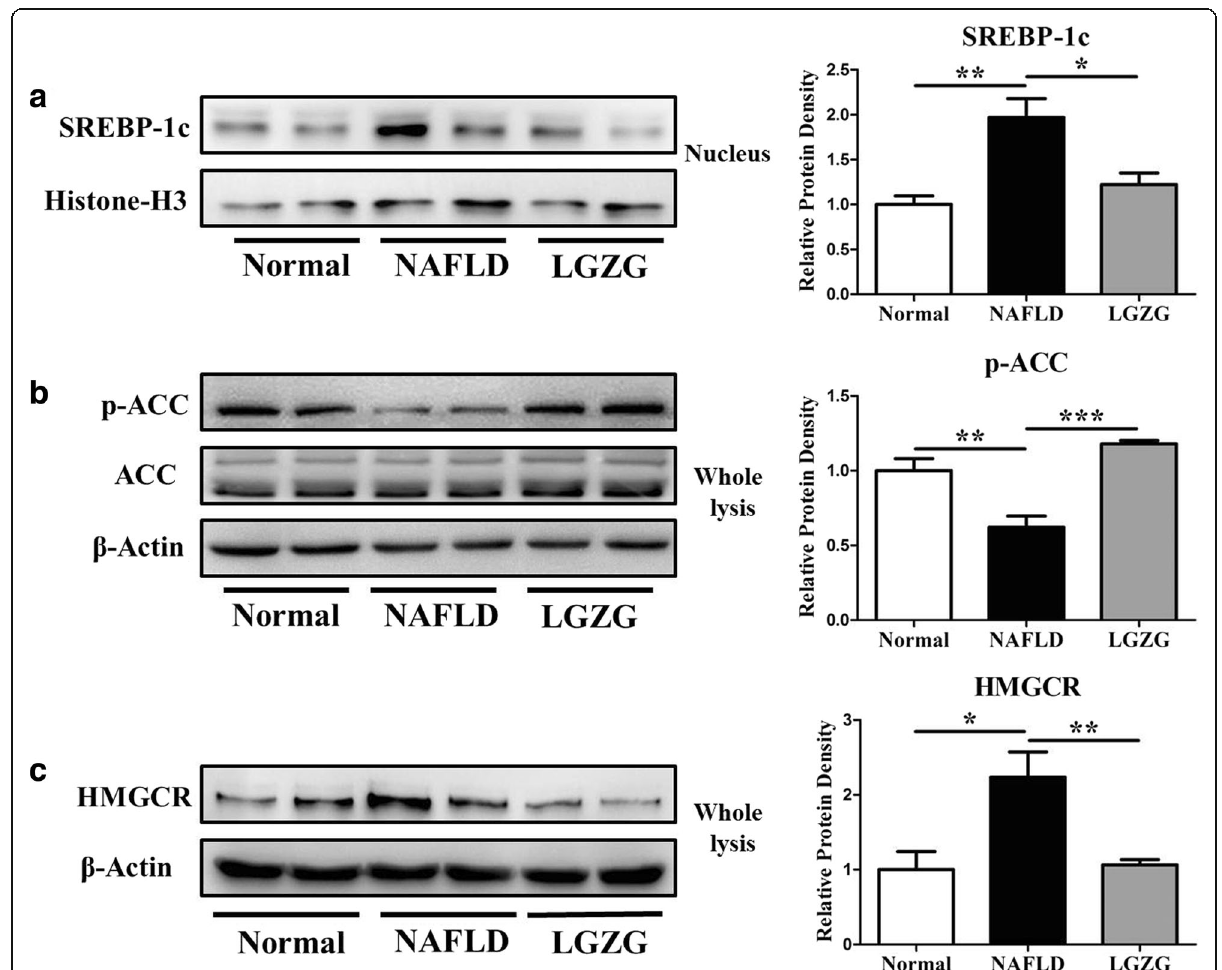
Fig. 5 LGZG inhibited hepatic de novo lipogenesis and cholesterol synthesis. a SREBP-1c protein expression in nucleus. b p-ACC and ACC protein expression. c HMGCR protein expression. Data were presented as means ± SEM ( n = 8 per group). * P < 0.05, ** P < 0.01, *** P <